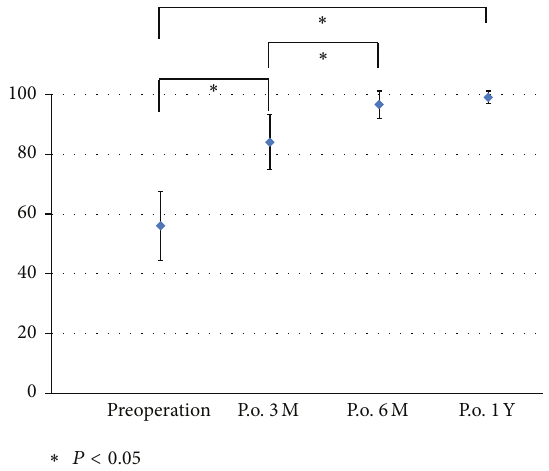
Figure 4: Functional ankle instability over the 1-year follow-up period. Three months after operative reconstruction, the score significantly increased ( 𝑃 < 0.05 ). The score increased further at 6 months and 1 year after operation.